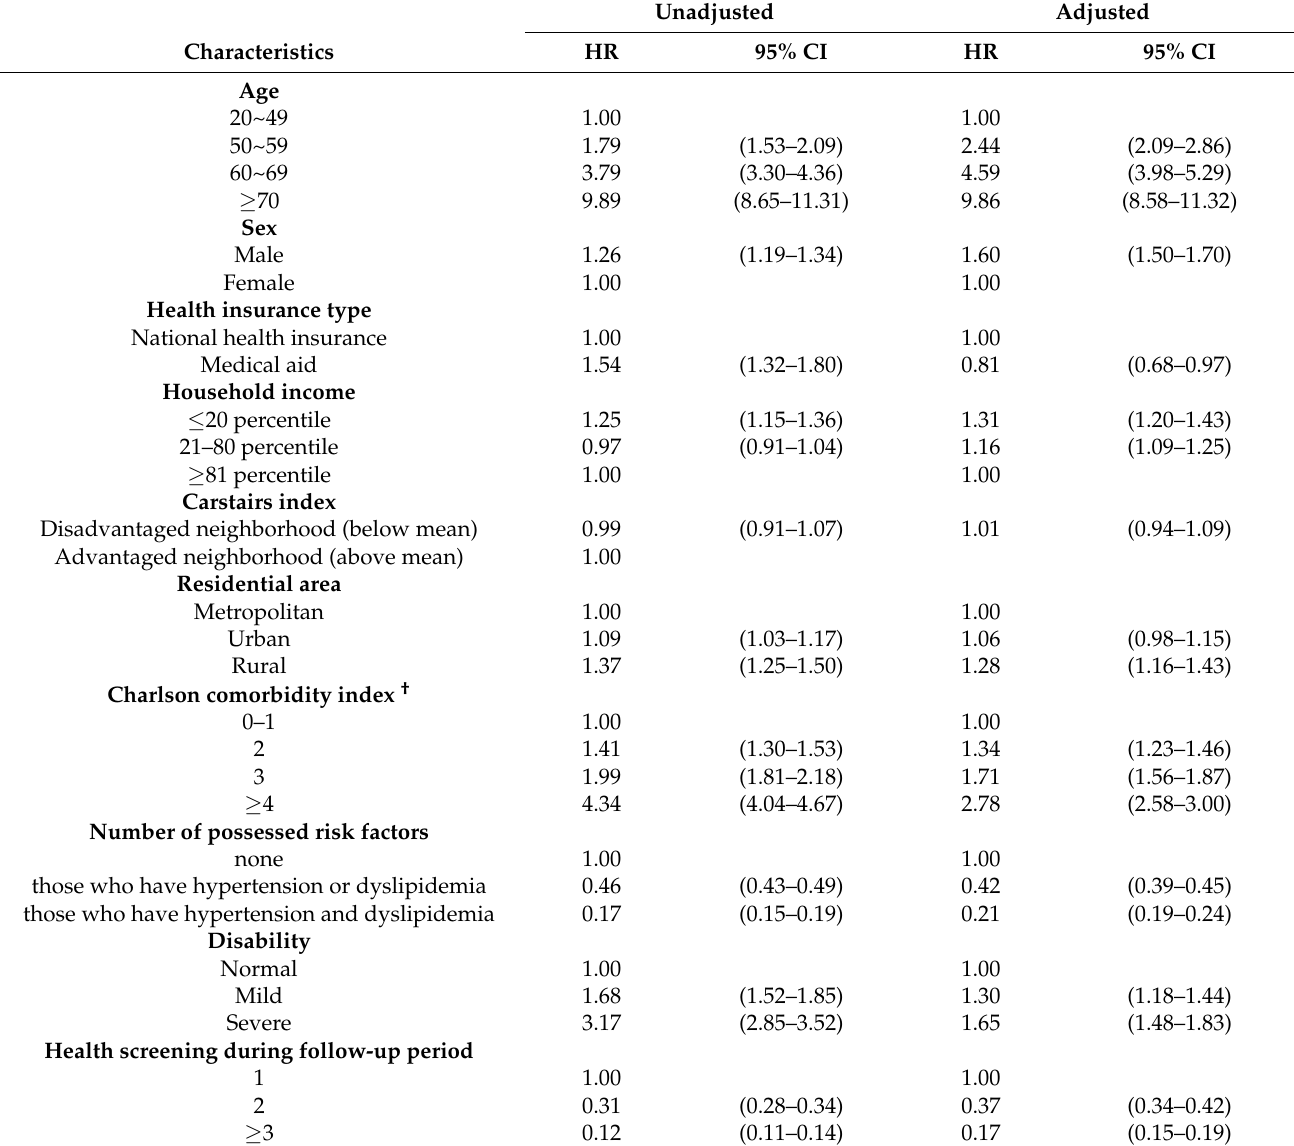
Table 2. All-cause mortality among newly diagnosed diabetics: hazard ratio ( n = 15,882). Unadjusted